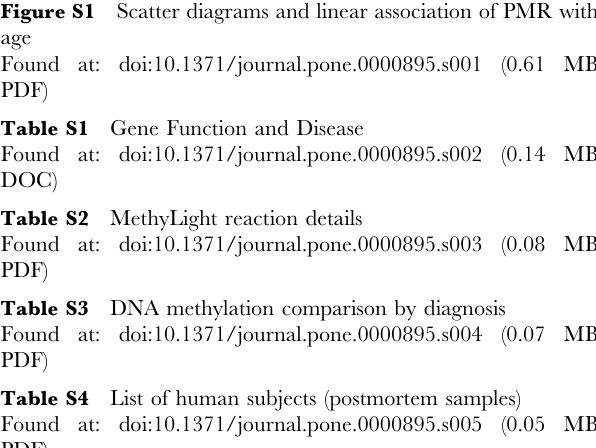
Figure S1 Scatter diagrams and linear association of PMR with